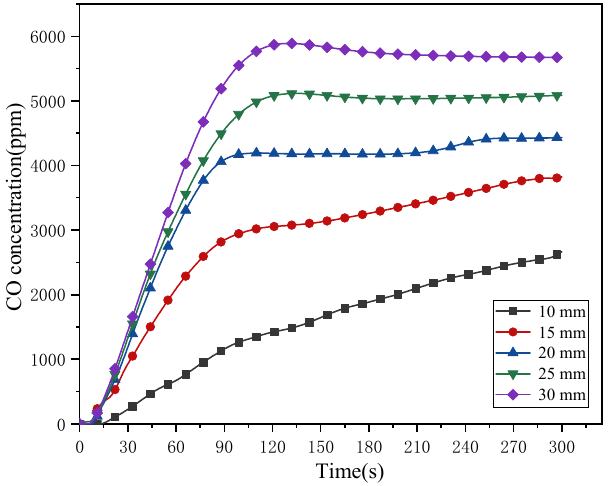
Figure 14. The CO concentration in transition room with 5 mm hole diameters.